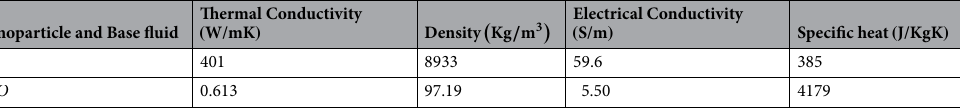
Table 1. Thermophysical characteristics of H 2 O / Cu 13 .